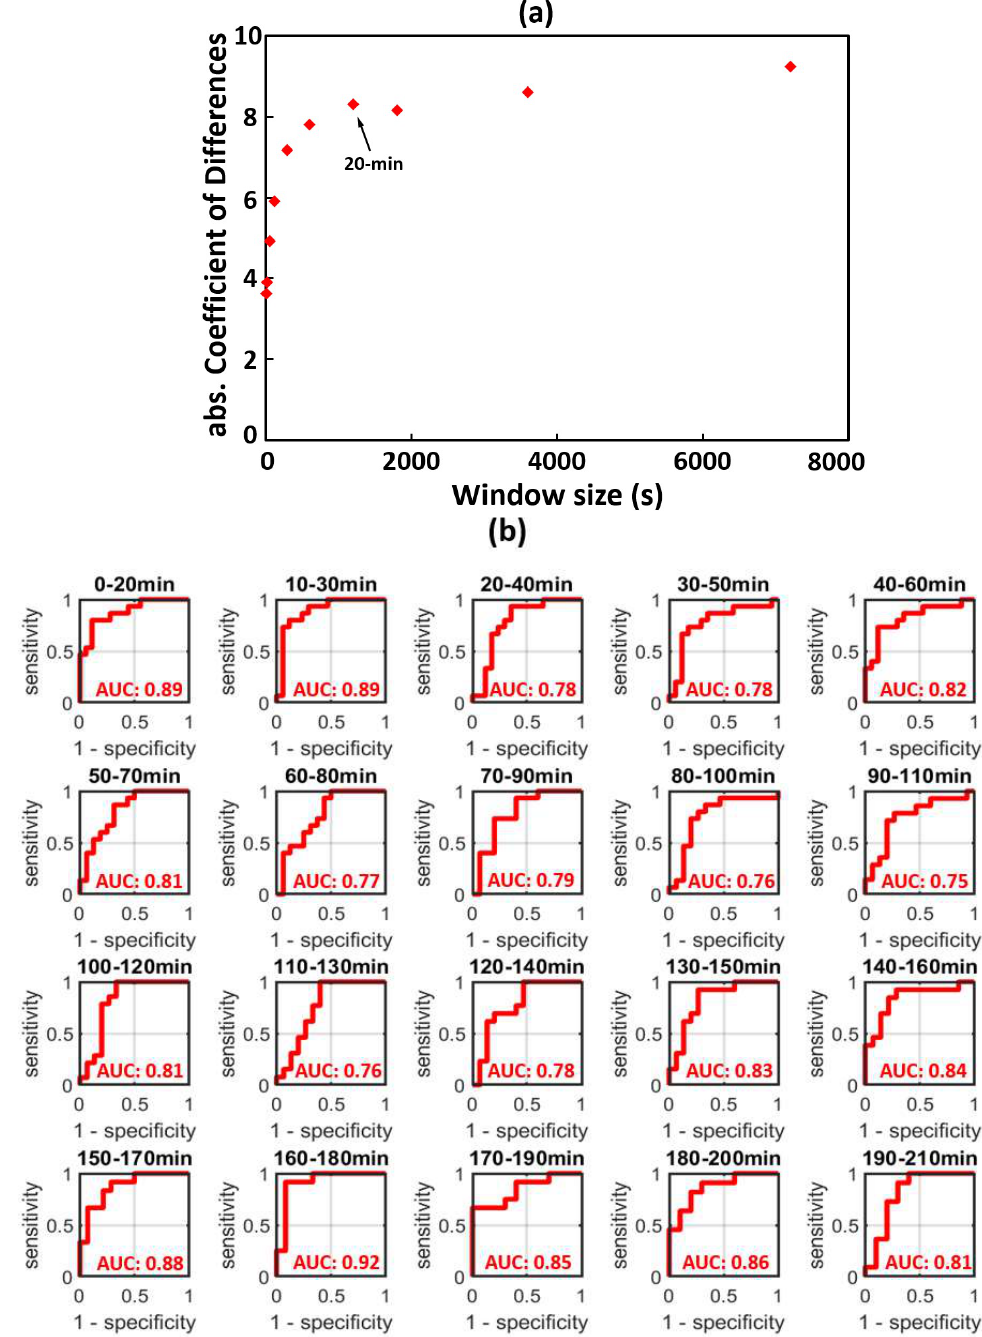
Figure 3. ( a ) Relationship of window sizes versus the absolute values of coefficient estimates for all 10 different windows. The red points denote the coefficients estimates for different window sizes in Table 2. The arrow indicates the shortest optimal window, 20 min, to separate the HIE mild and HIE cooled groups; ( b ) using 20-min window tPAC m , the time-dependent Area Under Curve (AUC) to classify the HIE mild neonates versus HIE cooled , at electrode P3. AUC: Area Under Curve. Therefore, 20 min window size was selected as the shortest window to optimize the separation of tPAC m indexes between HIE mild and HIE cooled .